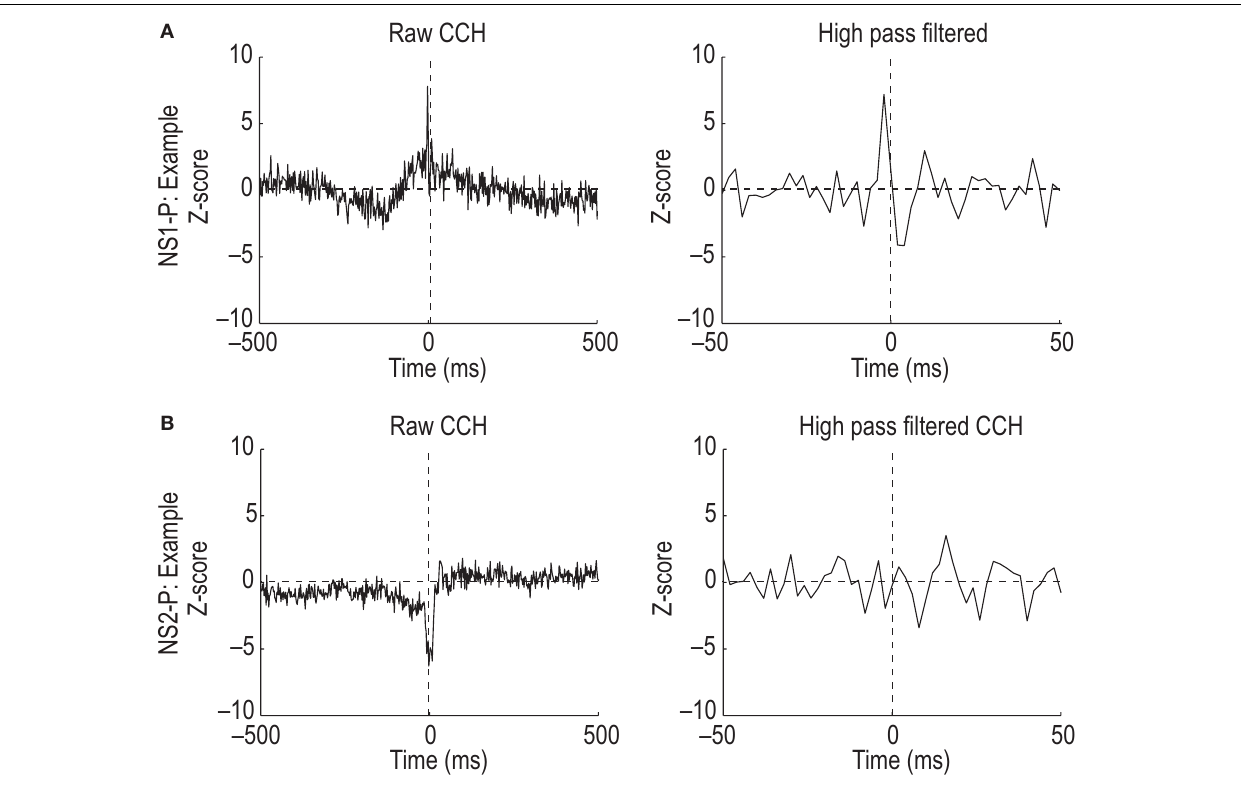
probability of the putative pyramidal cell just prior to a NS1 spike. Note the change in time axis. (B) Representative cross-correlation histogram (left) for a single NS2–WS cell pair. Firing probability of wide-spiking cell is plotted relative to the occurrence of spikes from the NS2 neuron (time = 0). High pass fi ltering of the CCH (right) reveals a lack of short latency spike train